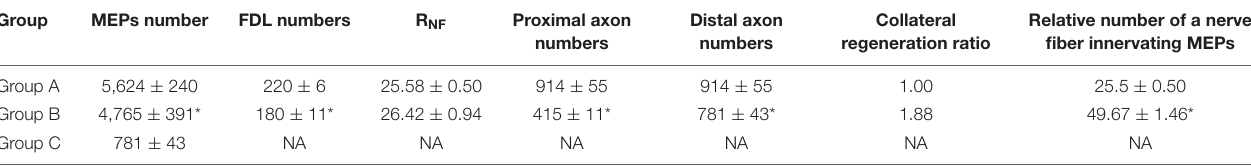
FIGURE 3 | The schematic diagram for measurement of the width of NMJs lamella clusters. Schematic diagram showing the cross-sectional images of LFD. Lamella clusters of MEPs in cross-sections were indicated by gray dots. The red line identifies the MIP images of nerve fibers in the cross-section. The yellow line represents the width of lamella clusters. TABLE 1 | Comparisons of the number of nerve fibers and NMJs across all